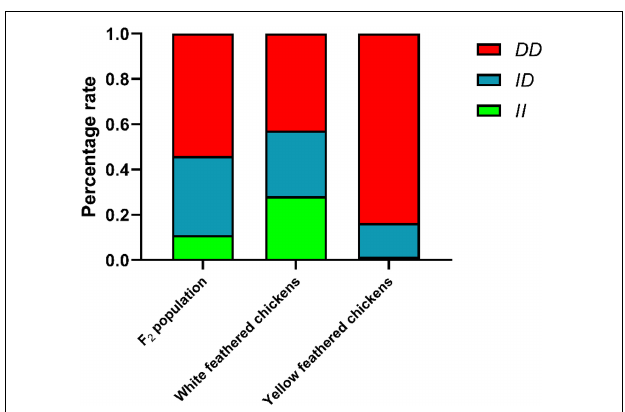
FIGURE 4 | Percentage of different genotypes in different populations. White feathered chickens (White recessive rock chickens and White leghorn chickens), yellow feathered chickens (Wenchang chickens, Qingjiaoma chickens, Lushi chickens, Guangxi yellow chickens, Gushi chickens, and Xinghua chickens).